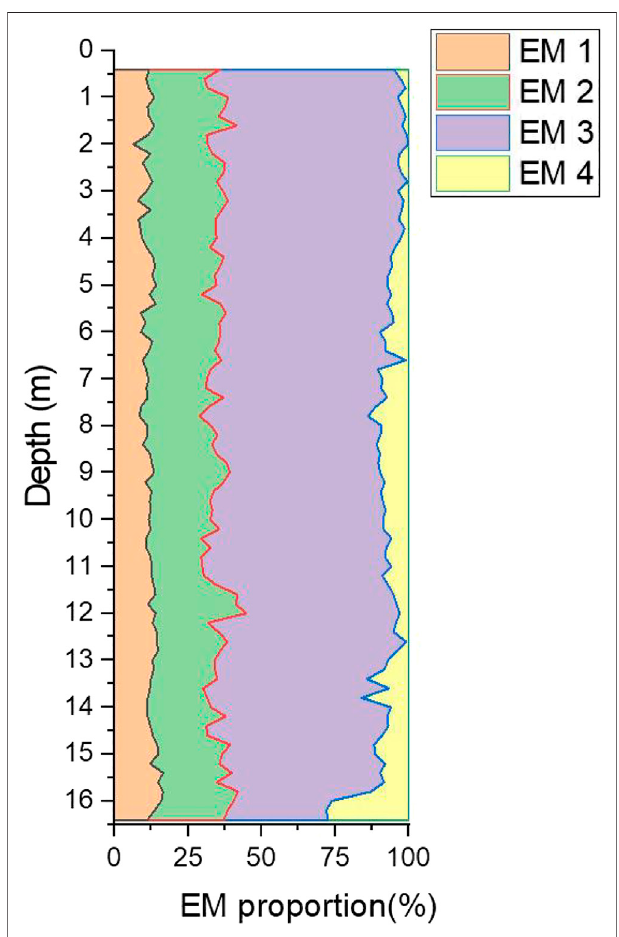
FIGURE 5 | Variations of End-members corresponding to sampling depth of XG pro fi